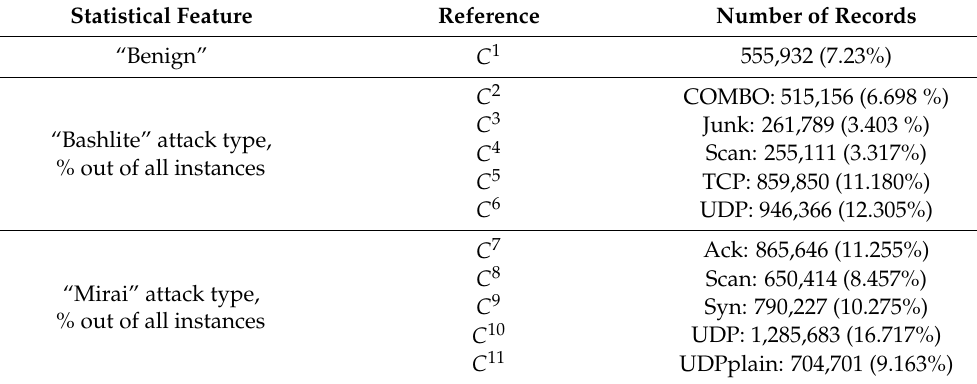
Table 2. The sampling of normal and attack classes in multi-class